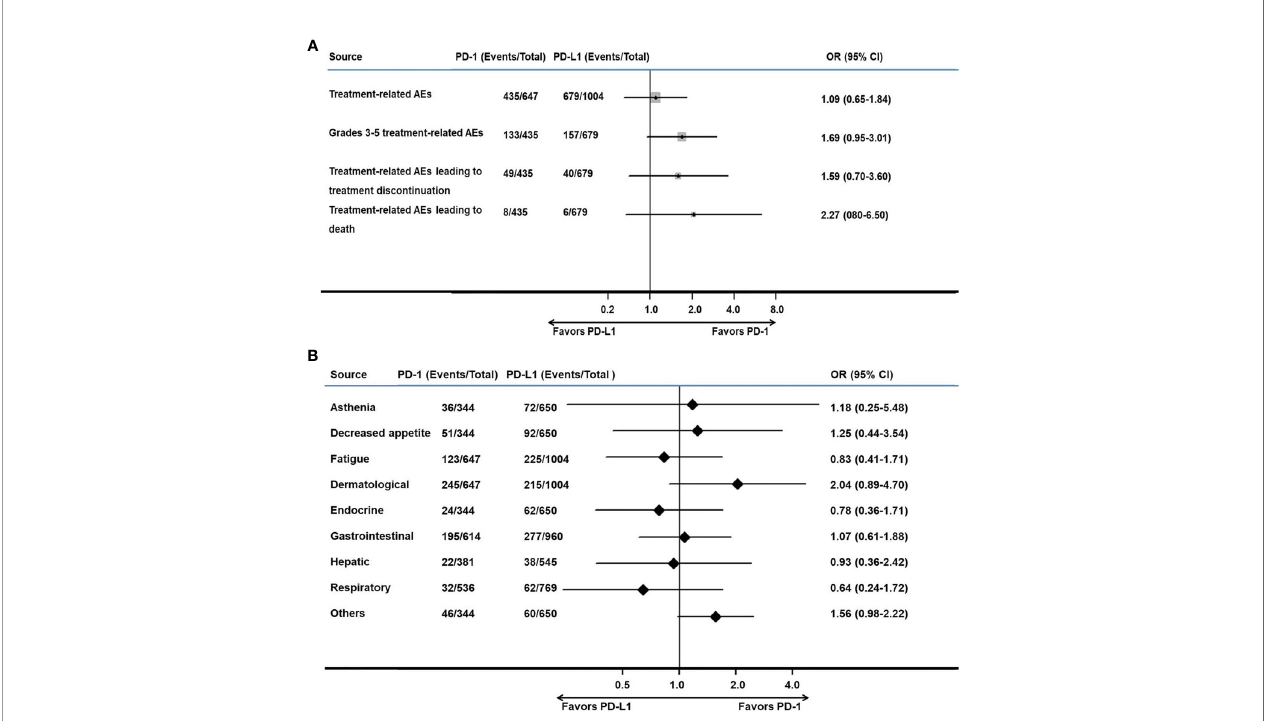
FIGURE 4 | Meta-analysis of pooled odds ratios of adverse events of anti – PD-1 versus anti – PD-L1 therapy. (A) adverse events with anti – PD-1 versus anti – PD-L1 therapy, (B) adverse events with an incidence ≥ 1% for anti – PD-1 versus anti – PD-L1 therapy.